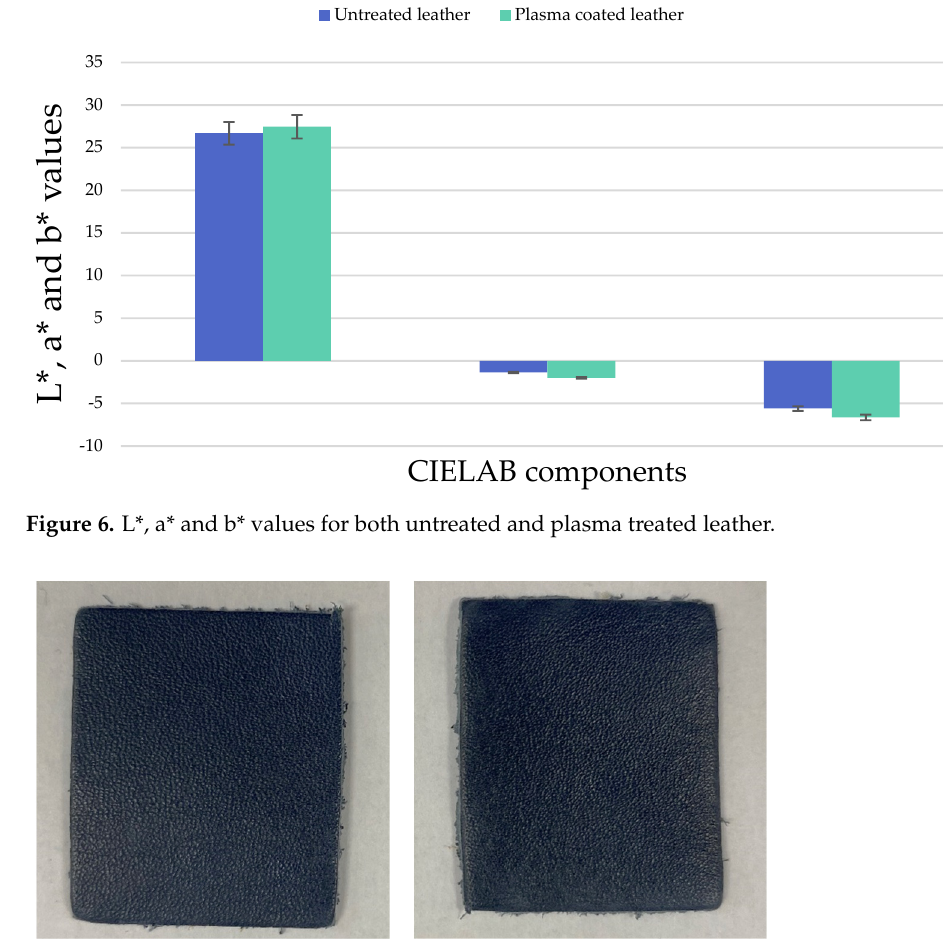
Table 6. Thickness values of untreated, plasma treated samples and plasma polymerised HMDSO coating.